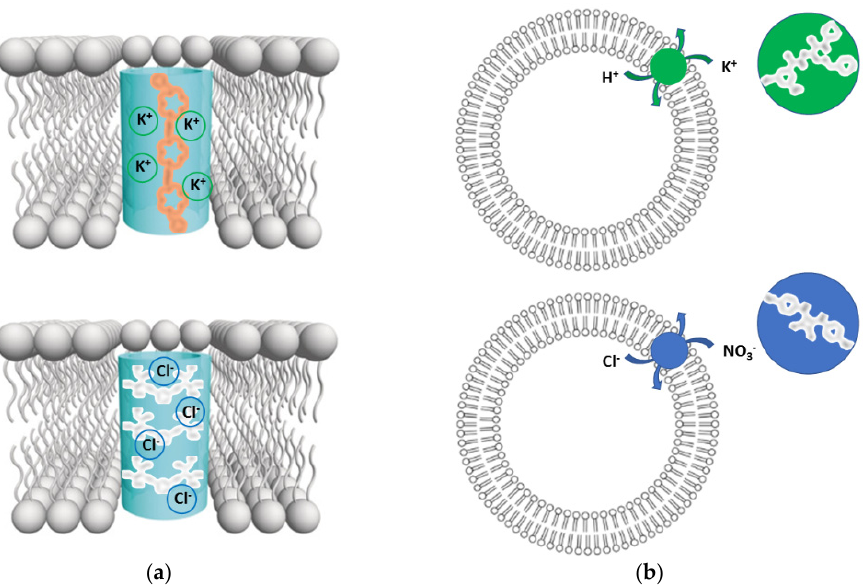
Figure 6. Examples of artificial ion ( a ) channels and ( b ) transporters for membrane insertion that derive from supramolecular-chemistry design.